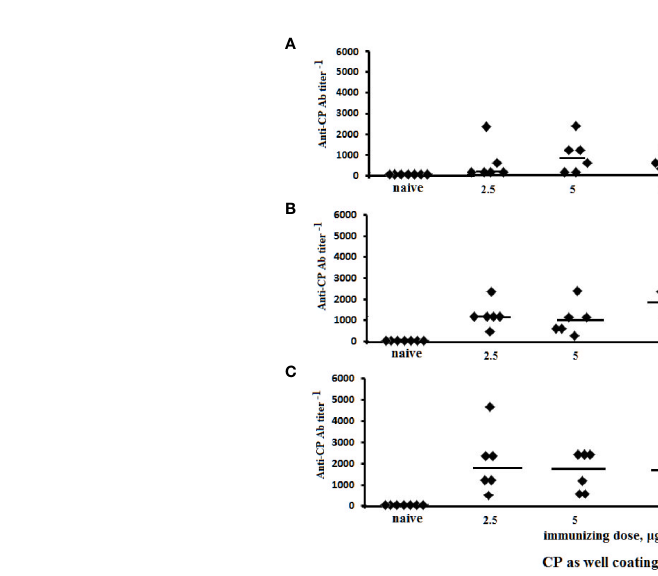
FIGURE 7 | Anti-CP IgG1 antibody (Ab) titers in BALB/c mice (n = 6) immunized intraperitoneally with di – BSA (A) , tri – BSA (B) , and tetra – BSA (C) conjugates adjuvanted with aluminum hydroxide. Controls: naïve mice (n = 18); mice (n = 6) injected with aluminum hydroxide (250 µg) diluted in saline (three assays per each sera); mice (n = 6) received CP – CRM 197 conjugate, 1.1 µg (three assays per each sera). Data represent individual anti-CP IgG1 Ab titers induced by glycoconjugates, bars indicate median ± SD. Mann – Whitney Rank Sum tests used to evaluate signi fi cance between the titer of Ab in anti-tetra – BSA compared with di – and tri – BSA antisera obtained from the mice immunized with 20 µg of the neoglycoconjugates, * P <